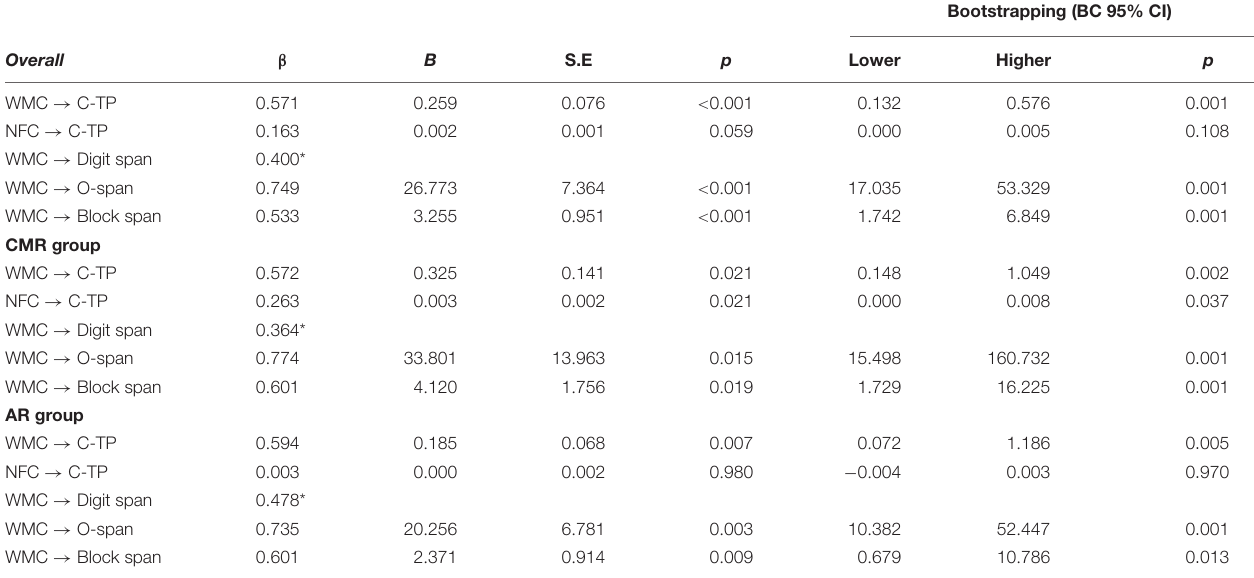
TABLE 3 | Path analyses with test task performance as dependent